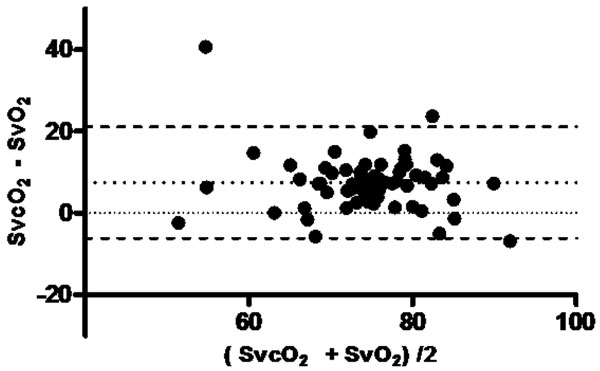
Bland-Altman (SvO2×SvcO2): bias 7.52, bias SD 6.957. 95% Limits of agreement: -6.116 to 21.16.